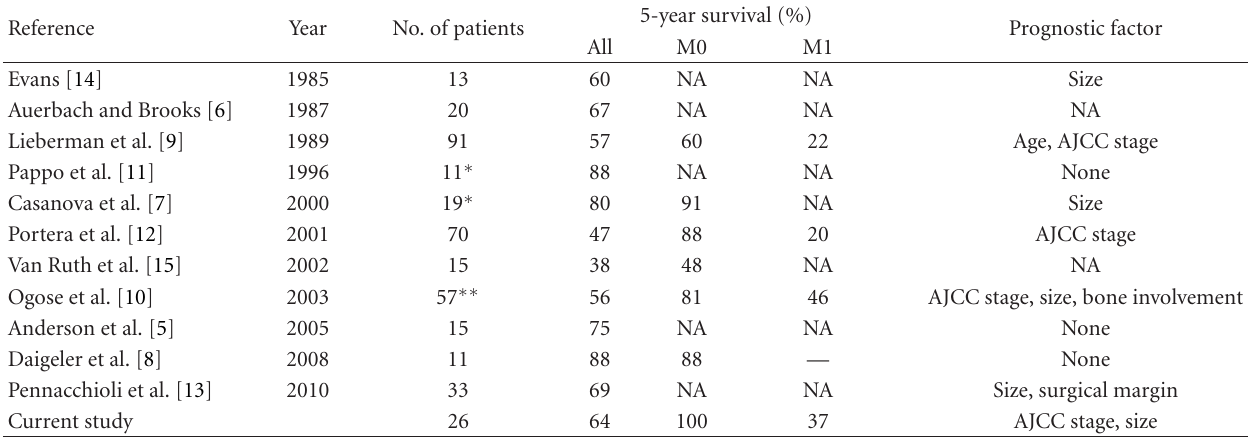
Table 1: Clinicopathologic studies of